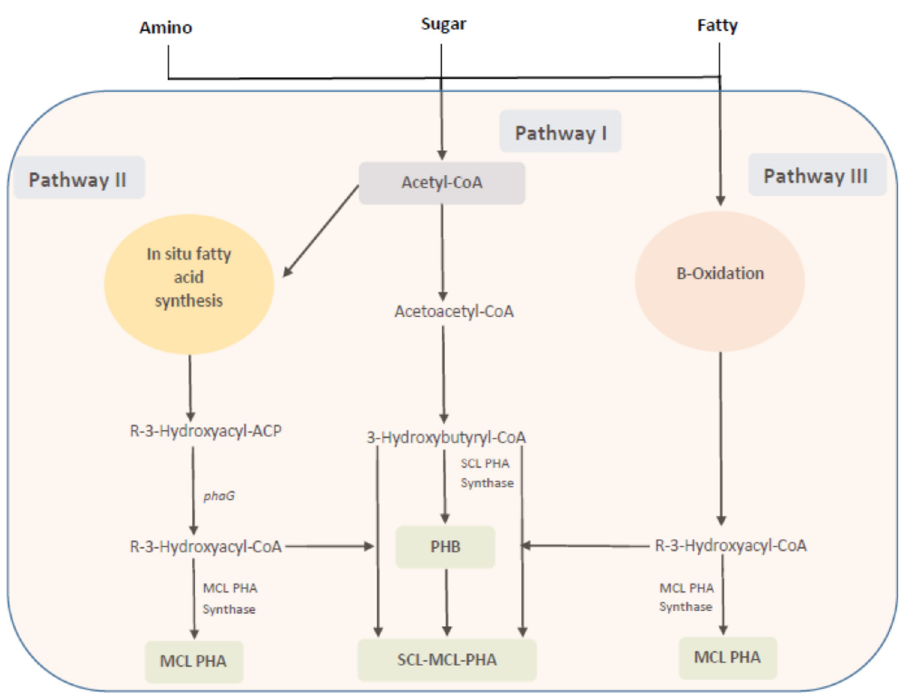
Figure 3. Biochemical pathway for PHA production in a microbial cell Redrawn from [52].